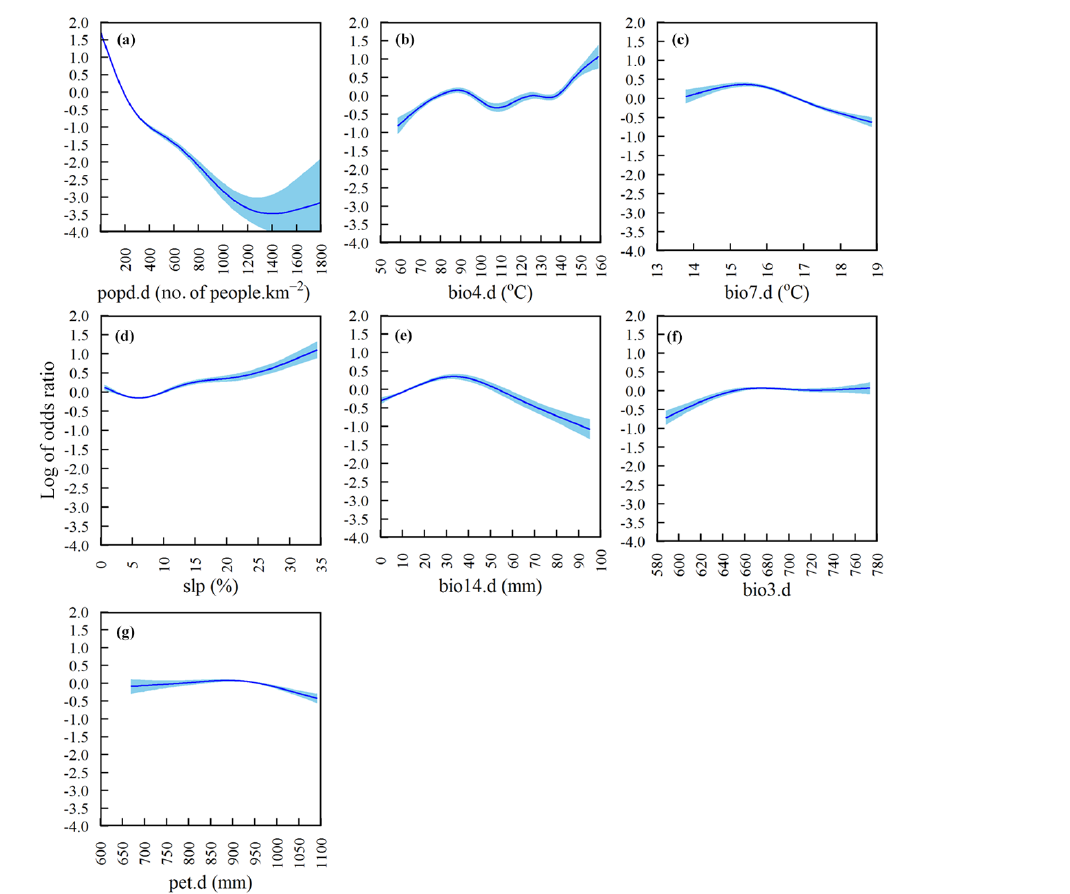
Figure 8. Partial functional plots relating the proportion (probability) of natural vegetation expressed as the log of odds ratio with (a) pop- ulation density (popd.d), (b) temperature, seasonality (bio4.d), (c) temperature annual range (bio7.d), (d) slope (slp), (e) precipitation of the driest month (bio14.d), (f) isothermality (bio3.d), and (g) potential evapotranspiration (pet.d). The probabilities are defined using a logistic model with cubic smoothing splines ( N =